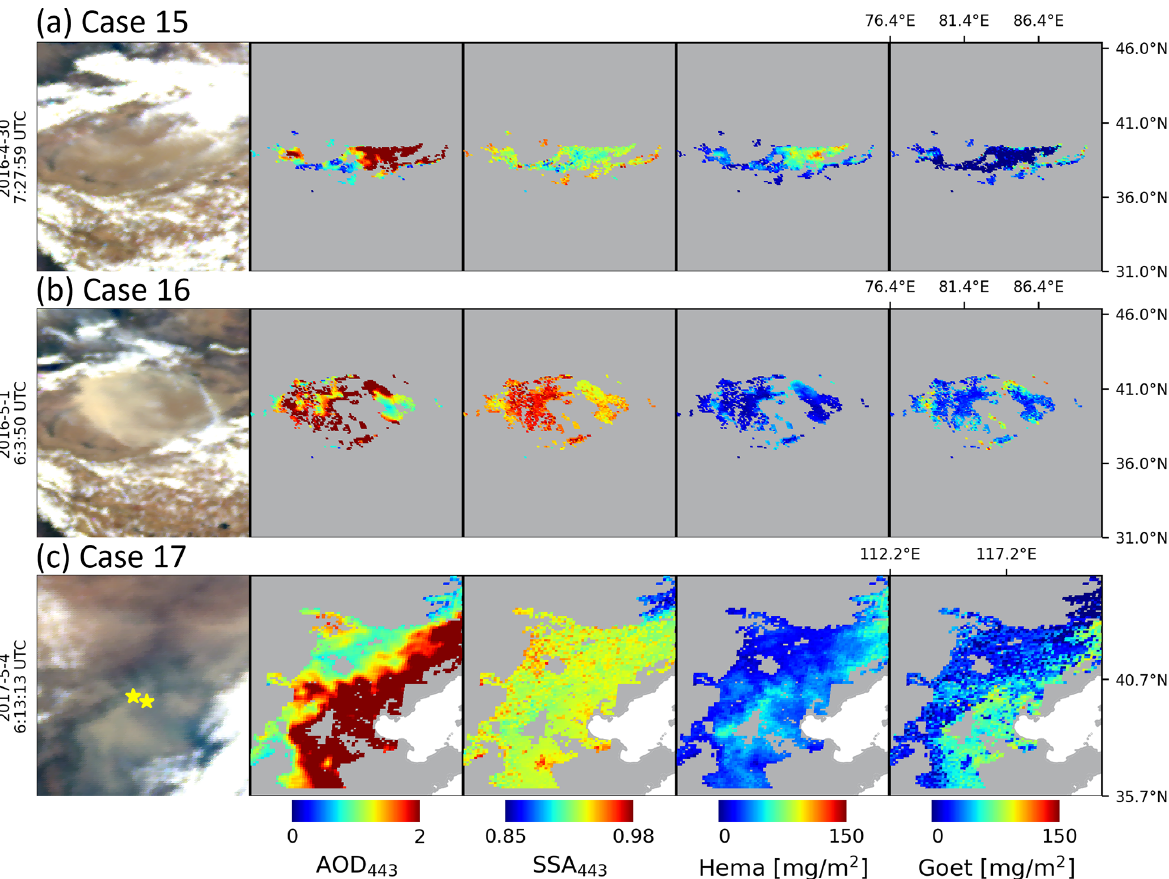
Figure A4. Dust episodes over the Taklimakan (rows 1 and 2) and Gobi (row 3) deserts. From left, RGB TOA image generated from EPIC L1B version 3 data, AOD 443nm, SSA 443nm, hematite mass concentration, and goethite mass concentration for each case: case 15 (row 1), dust episode on 30 April 2016; case 16 (row 2), dust episode on 1 May 2016; and case 17 (row 3), dust episode on 4 May 2017. Yellow stars over case 17 (row 3) indicate AERONET sites at Beijing (39.977 ◦ N, 116.381 ◦ E), Beijing_RADI (40.005 ◦ N, 116.379 ◦ E), and XiangHe (39.754 ◦ N, 116.962 ◦ E).